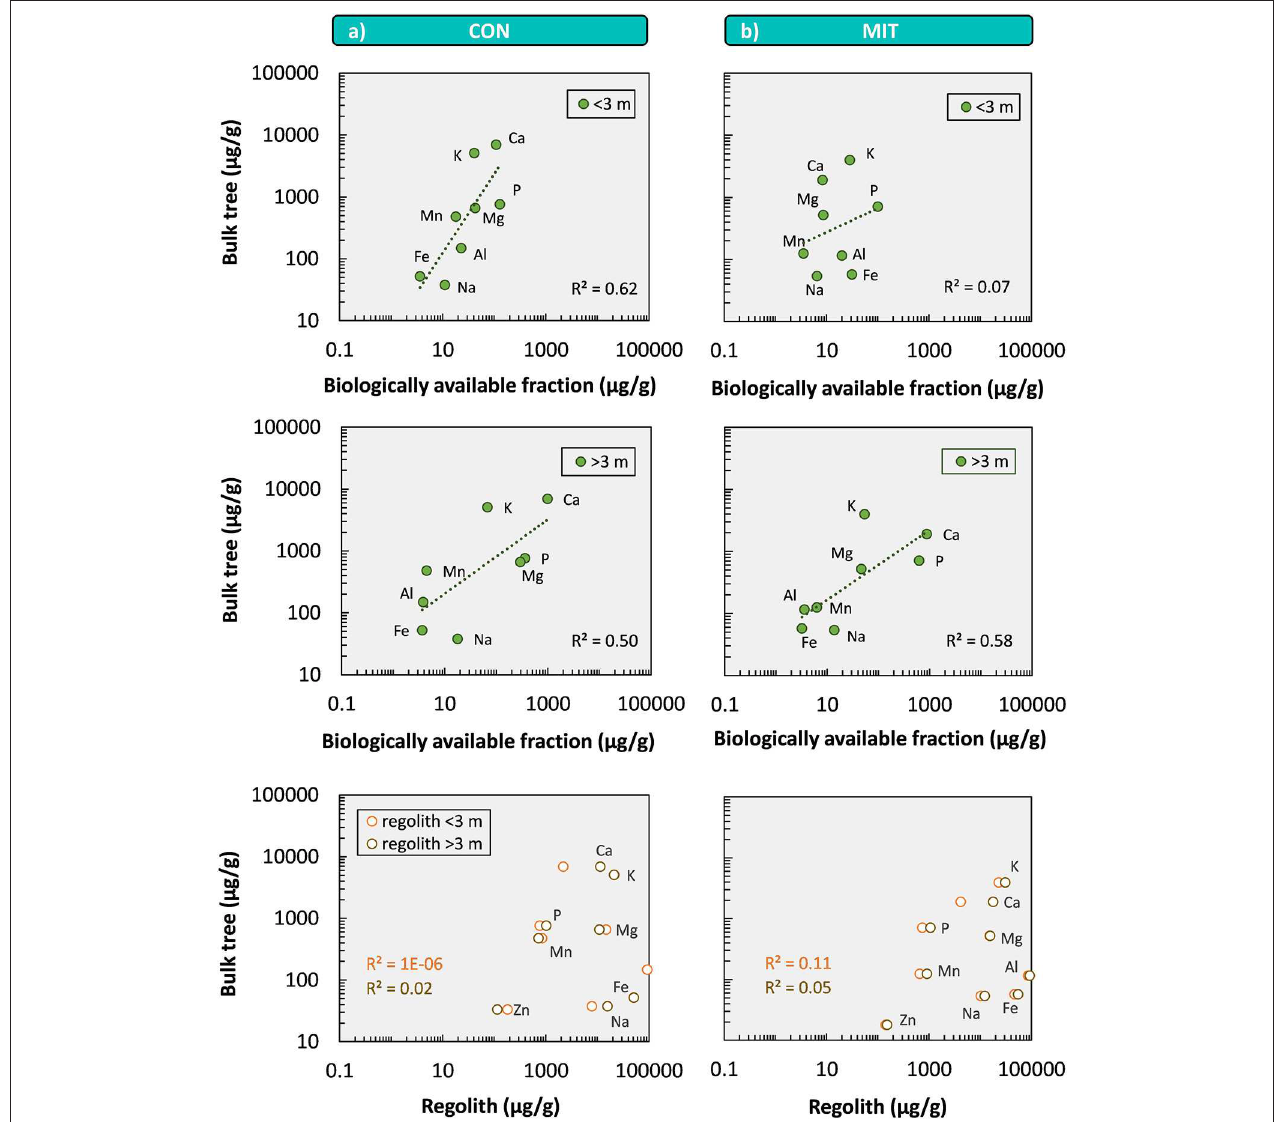
FIGURE 9 | Ecological stoichiometry shown by element concentrations of bulk tree (average of Fagus sylvatica and Picea abies ) vs. element concentrations of the biologically available fractions above 3m depth ( < 3m) and below 3m depth ( > 3m), and regolith above and below 3m depth at CON (a) and MIT (b) . Zn concentrations of the biologically available fraction were below the limit of detection.